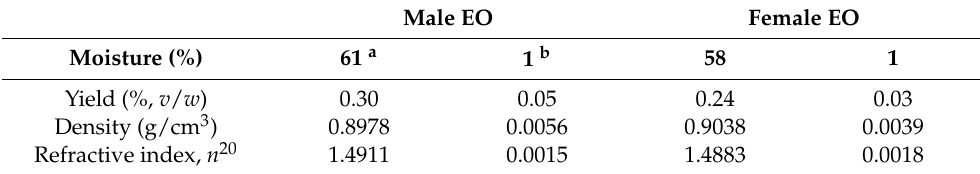
Table 1. Moisture and yield of the leaves and physical properties of the essential oil (EO). Male EO Female EO Moisture (%) 61 a 1 b 58 1 Yield (%, v / w ) 0.30 0.05 0.24 0.03 Density (g/cm 3 ) 0.8978 0.0056 0.9038 0.0039 Refractive index, n 20 1.4911 0.0015 1.4883